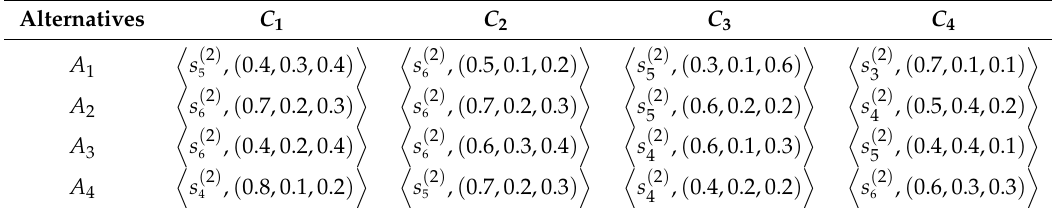
Table 5. Standardized SVNL decision matrix R 2 .